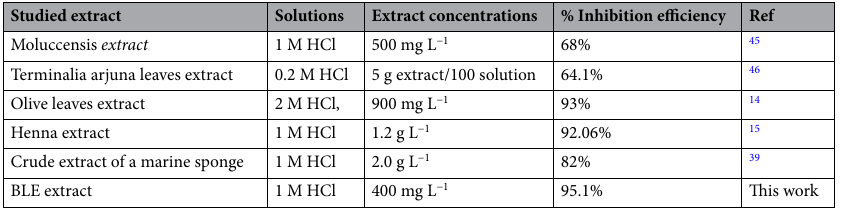
Table 5. Comparative studies have been done on extract green inhibitors for steel in acidic